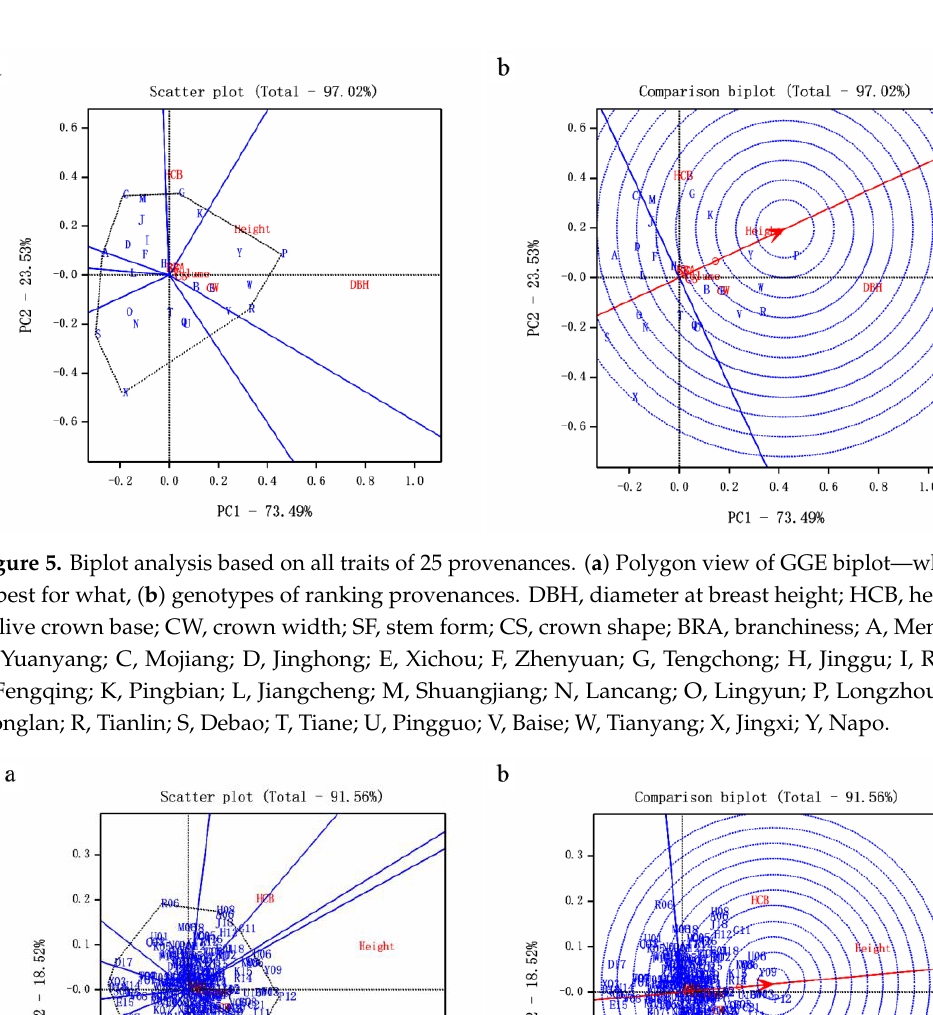
Figure 5. Biplot analysis based on all traits of 25 provenances. (a) Polygon view of GGE biplot—which is best for